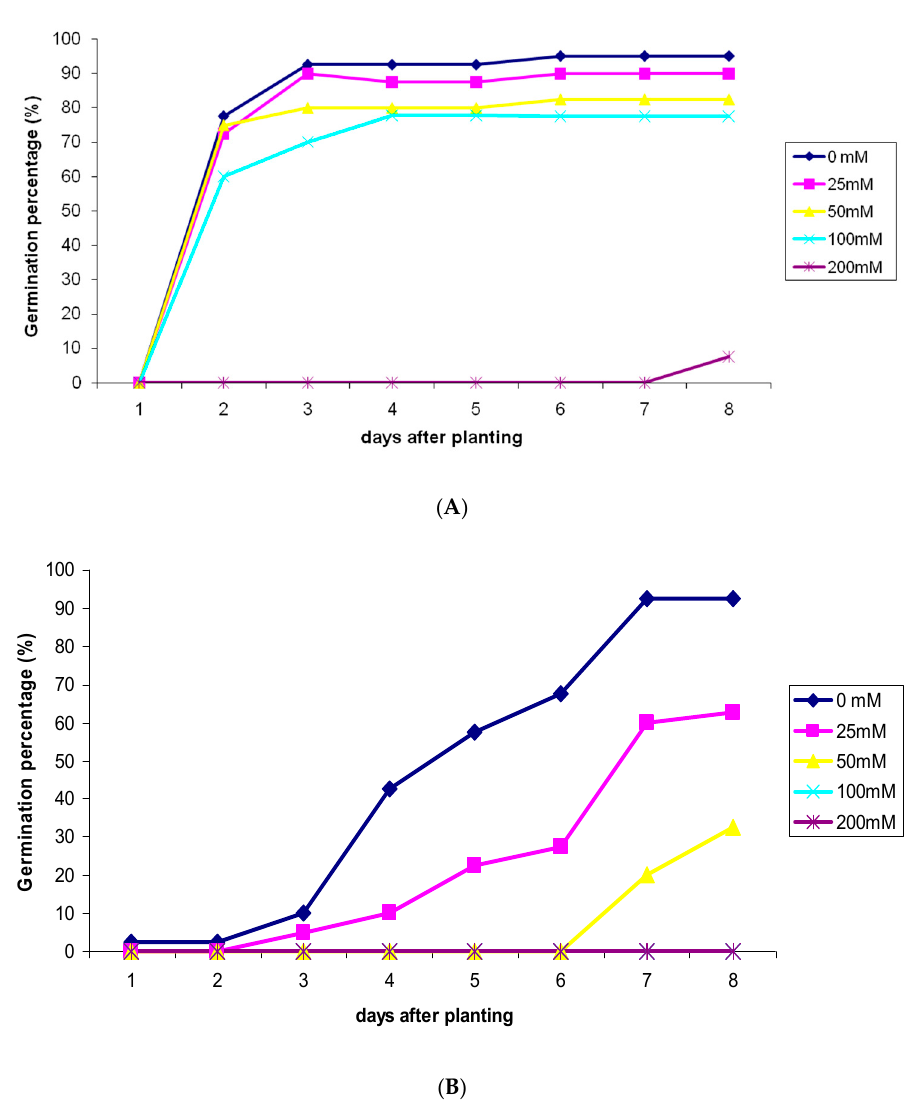
Figure 1. Effect of salinity stress on germination rate in cucumber ( A ) and tomato ( B ) . Figure 1. E ff ect of salinity stress on germination rate in cucumber ( A ) and tomato ( B